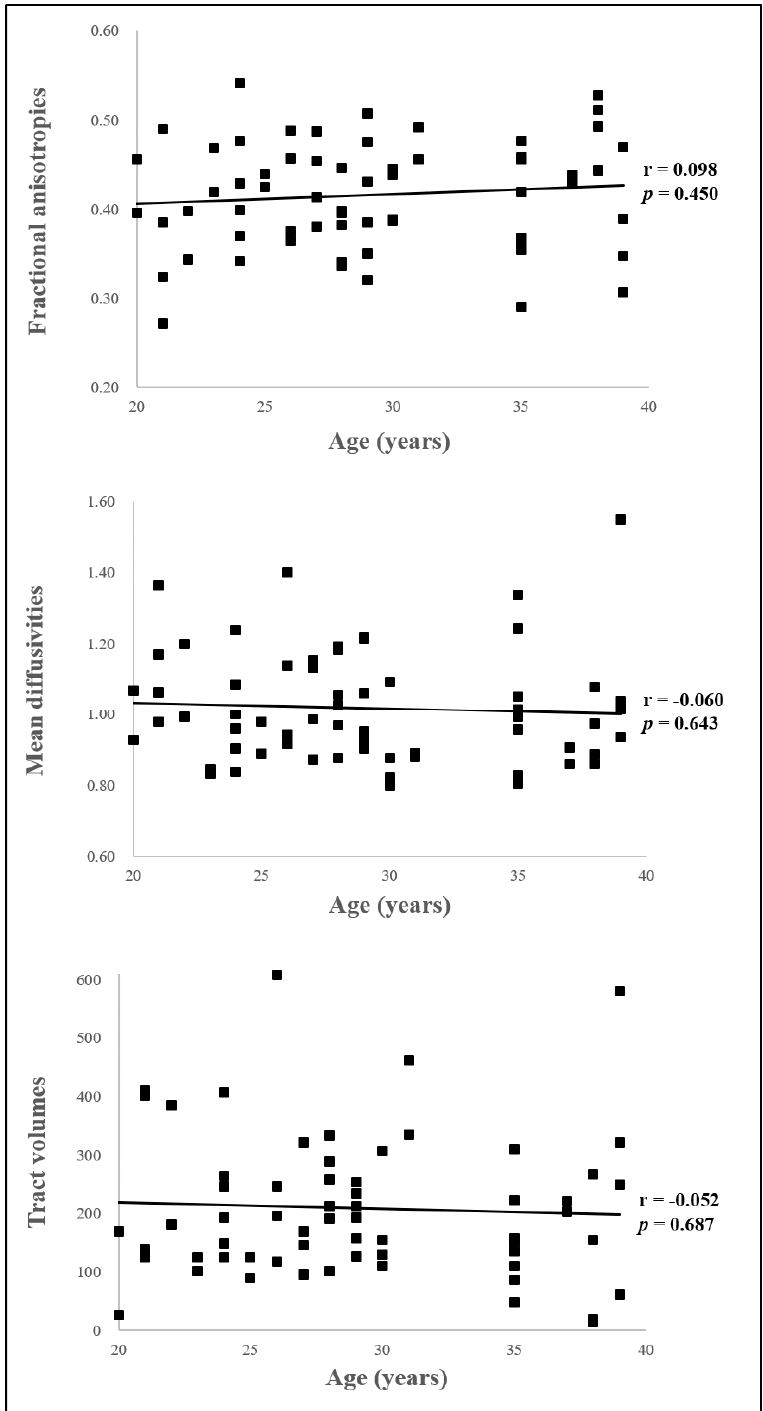
Figure 3. Correlation between age and diffusion tensor imaging (DTI) parameters . There was no significant correlation between age and all DTI parameters ( p > 0.05).